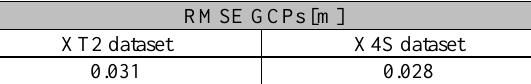
Table 10. Mean errors on GCPs for DLSR camera dataset and thermal